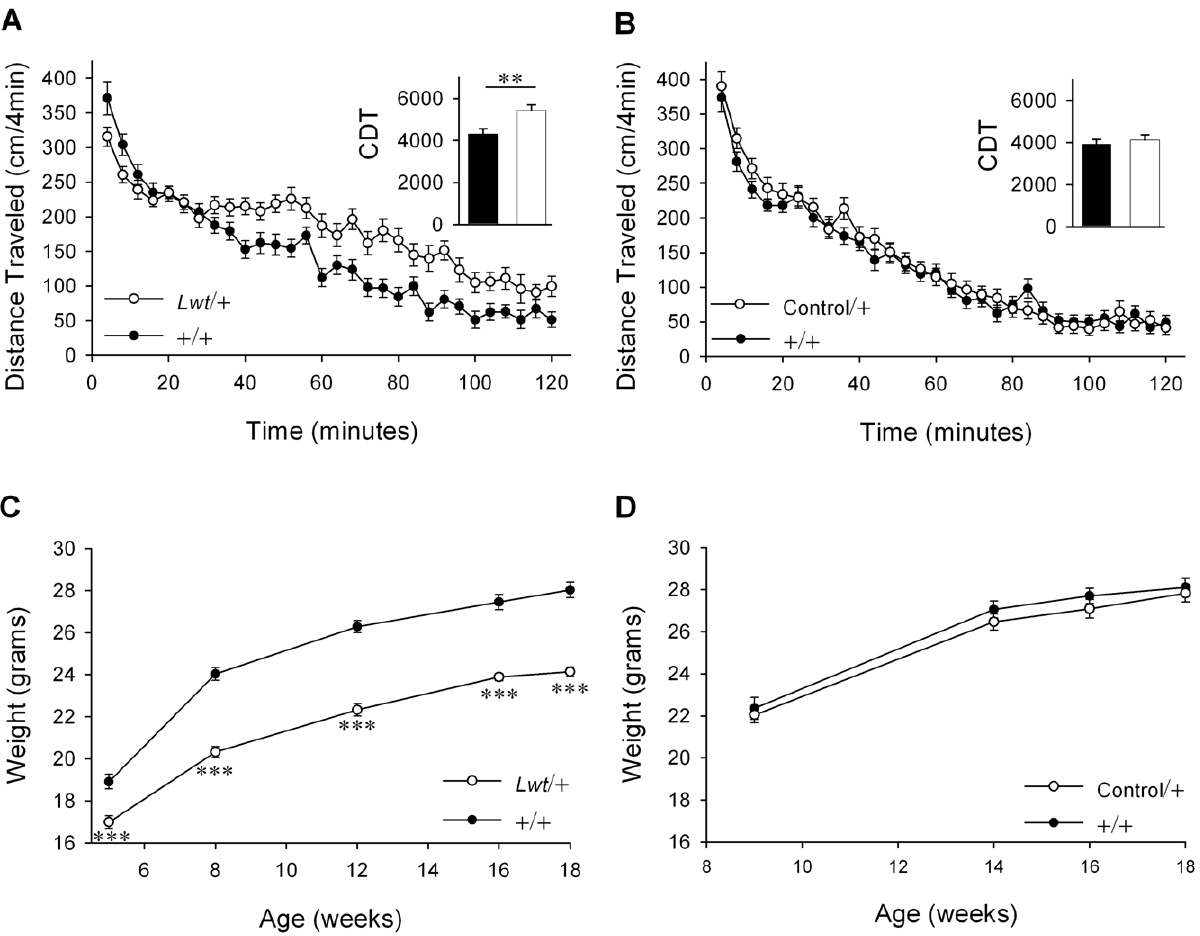
Figure 4. B6.D2- Unc-79 Lwt ( Lwt ) congenic strain captures locomotor and body weight phenotypes. (A) Spontaneous locomotor activity was assayed in + / + (n=34) and Lwt / + (n=26) male littermates. Inset: Cumulative distance traveled (CDT) over two hours (in centimeters) in Lwt / + males (white bar) was significantly higher than in + / + (black bar) littermates (** P , 0.01, Student’s t-test). (B) Congenic strain B6.D2.12D heterozygotes (denoted here and elsewhere as Control/ + ) was used to control for polymorphic differences between the B6 and D2 strains on mouse distal chromosome 12. There was no significant difference between + / + (n=34) and Control/ + (n=34) male littermates in locomotor activity. Inset: Cumulative distance traveled (CDT) over two hours (in centimeters) did not differ significantly between Control/ + (white bar) and + / + (black bar) male littermates (Student’s t-test). (C) At all ages tested Lwt / + (n=13) male animals weighed less than their + / + (n=15) littermates (*** P , 0.001, post hoc Tukey test). (D) Control/ + (n=15) and + / + (n=15) male littermates did not differ significantly in body